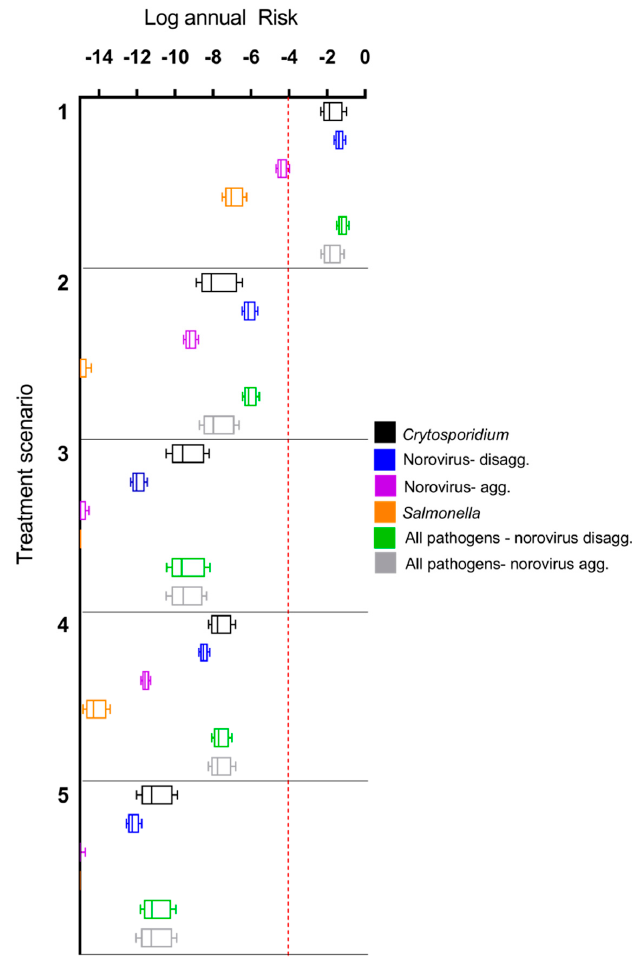
Figure 2. Comparison of annual risks for treatment scenario (1) (de facto reuse) and direct